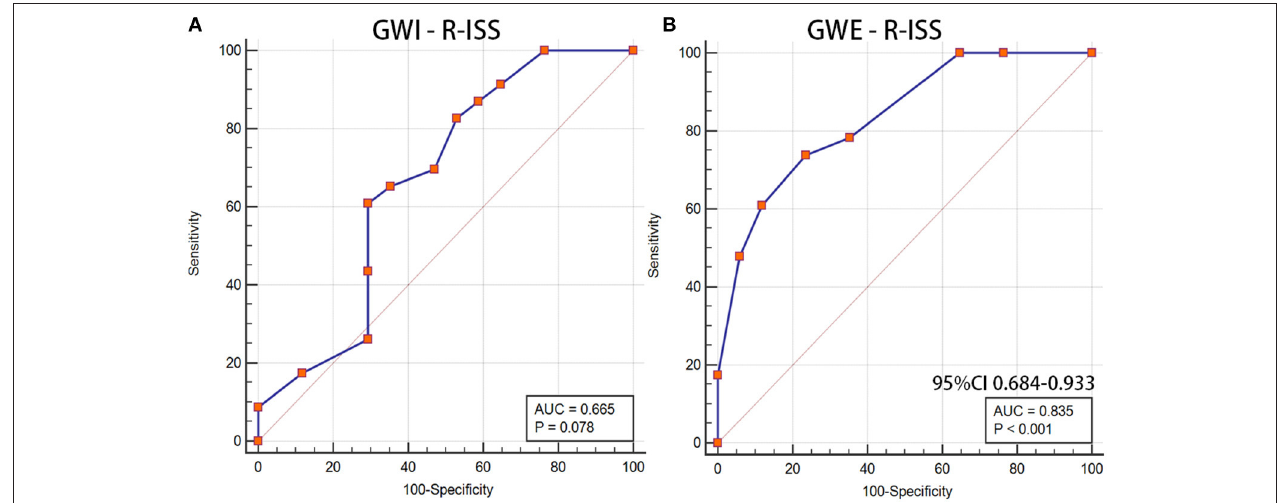
FIGURE 4 | GWI and GWE as a reference to assess the R-ISS of patients with MM. (A) LV GWI, (B) LV GWE. GWI, global work index; GWE, global work efficiency; R-ISS, Revised International Staging System; MM, multiple myeloma; LV GWI, left ventricular GWI; LV GWE, left ventricular GWE.